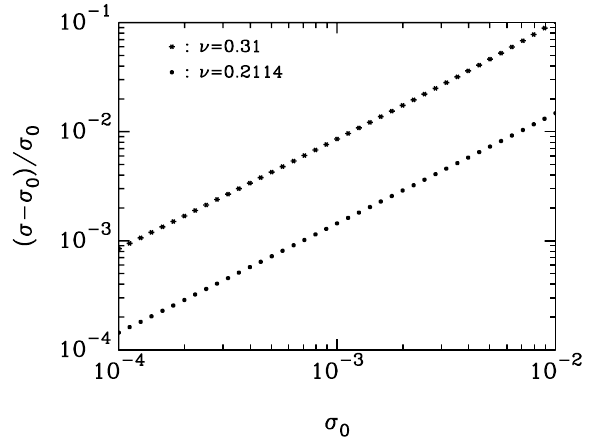
FIG. 4. The relative increase of the asymptotic equilibrium value of the rms emittance s as a function of the initial value s (cid:48) for the Hénon map with n (cid:173) (cid:48)(cid:46)(cid:50)(cid:49)(cid:49)(cid:52) (solid circles) and n (cid:173) (cid:48)(cid:46)(cid:51)(cid:49) (stars) calculated by using the moment map (69).